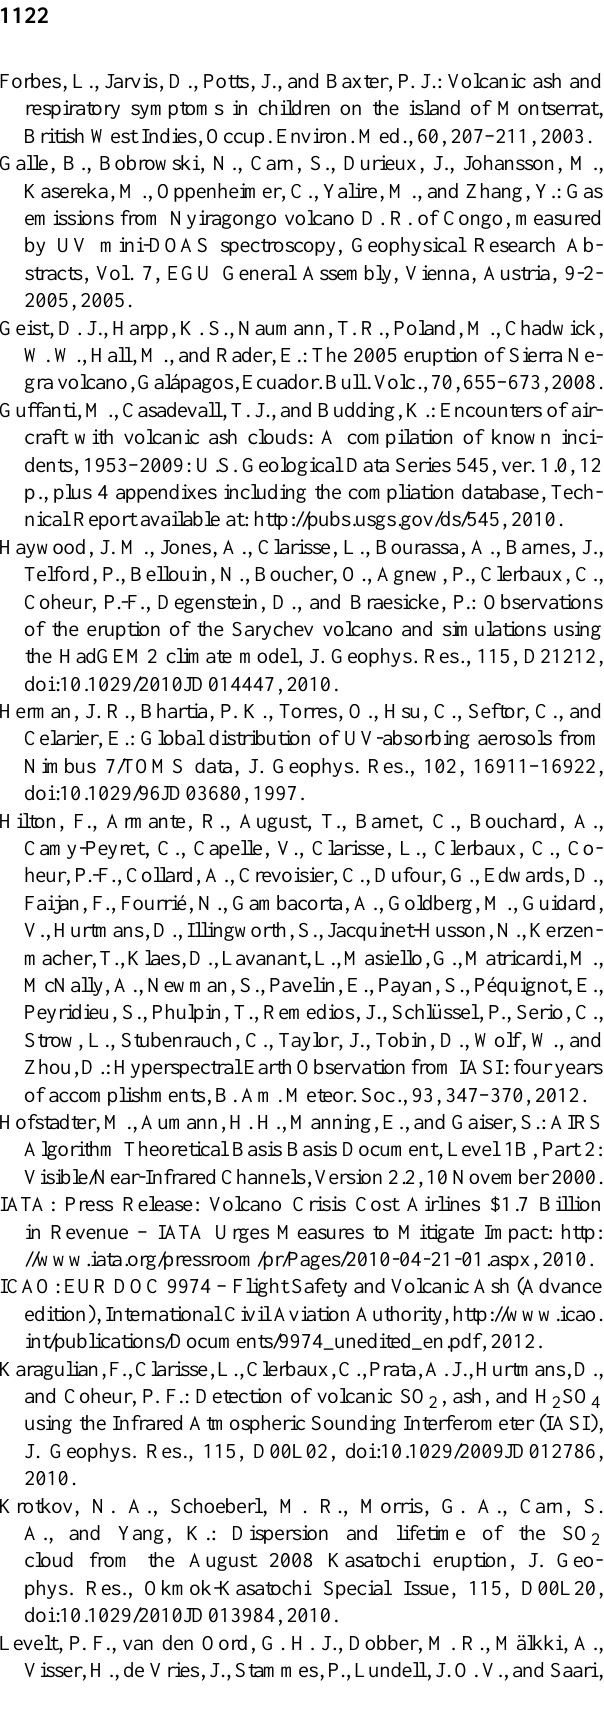
Algorithm Theoretical Basis Basis Document, Level 1B, Part 2: Visible/Near-Infrared Channels, Version 2.2, 10 November